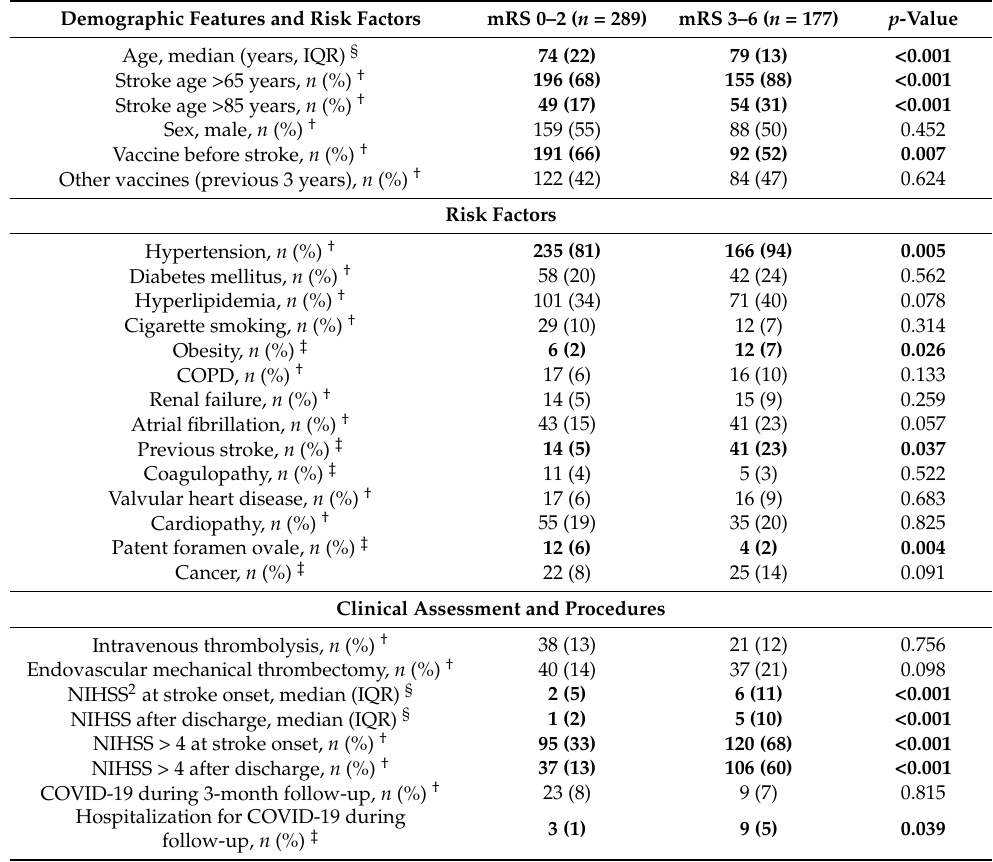
Table 2. Demographic and clinical features of stroke patients according to good (mRS 0–2) and poor (mRS 3–6)